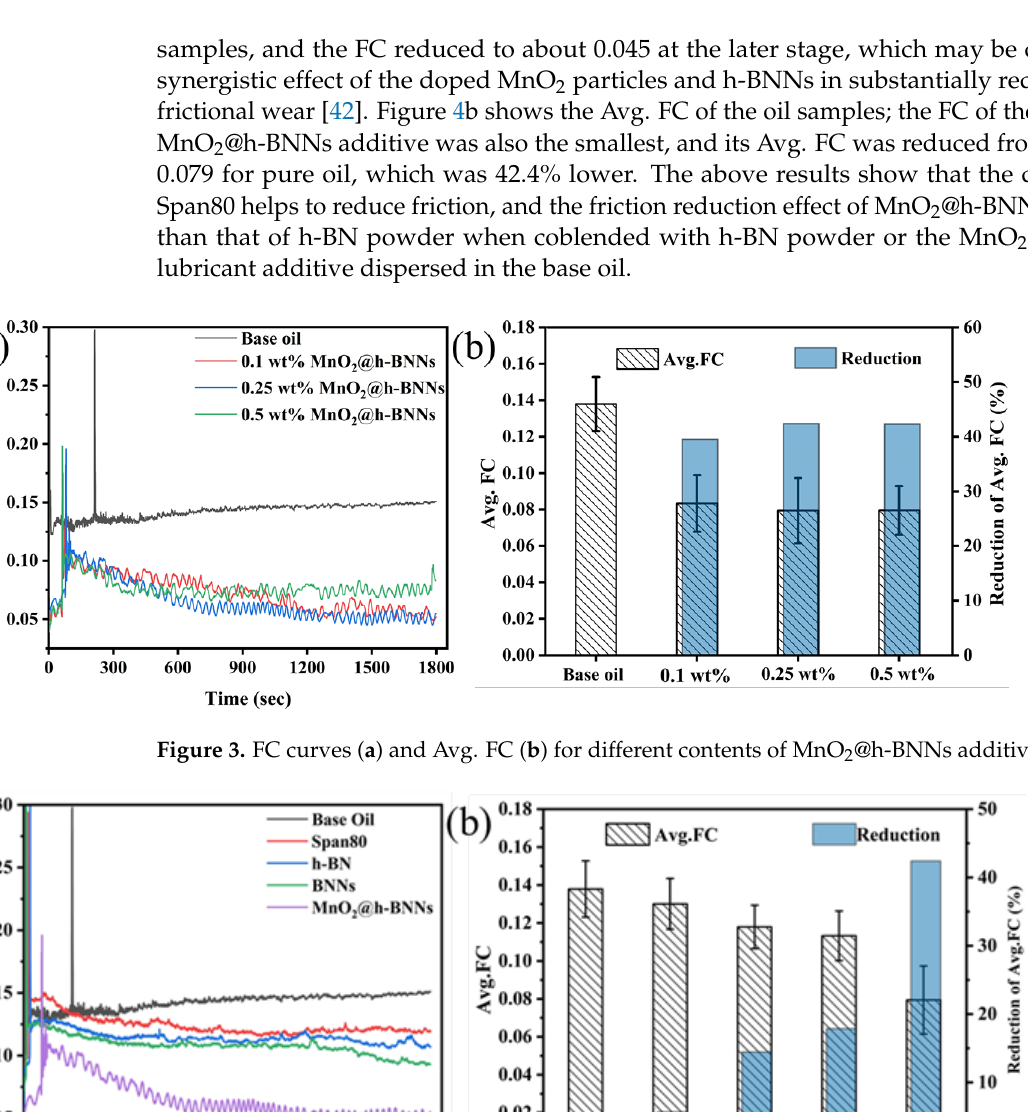
Figure 3. FC curves ( a ) and Avg. FC ( b ) for different contents of MnO 2 @h-BNNs additives.